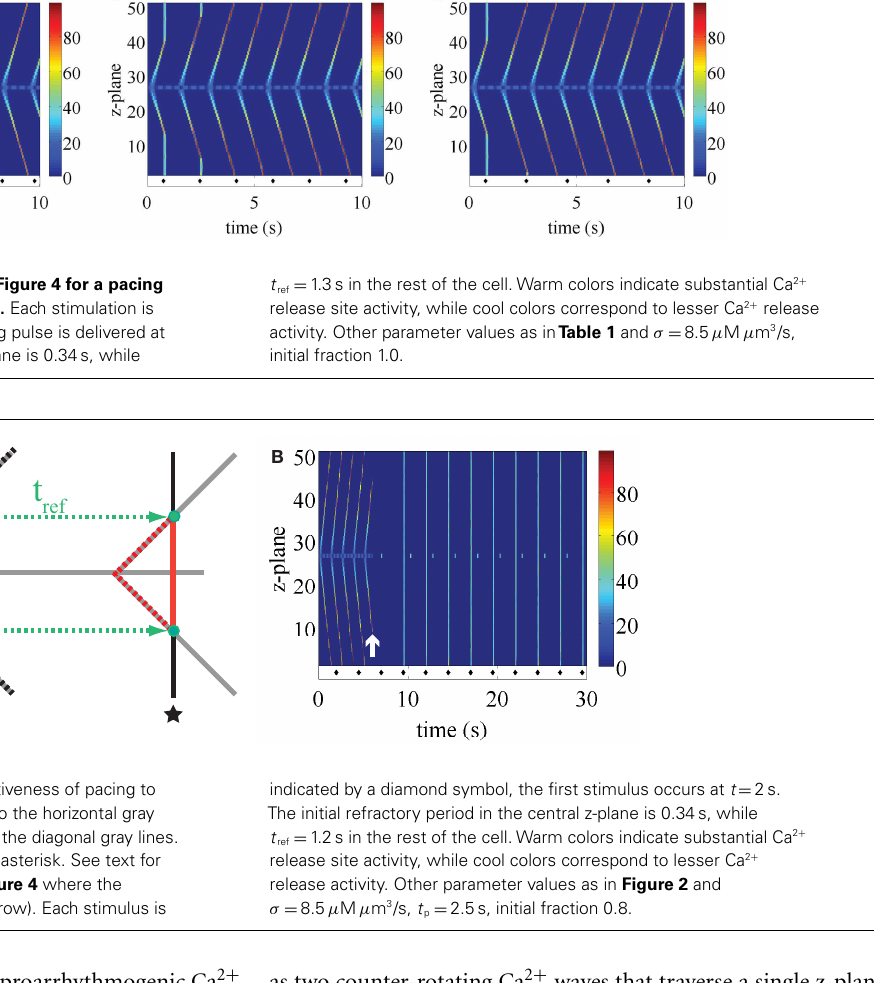
FIGURE 7 | (A) Cartoon illustrating the ineffectiveness of pacing to stop ping waves.The ping wave corresponds to the horizontal gray line, while the longitudinal wave is denoted by the diagonal gray lines. The pacing occurs at the time indicated by the asterisk. See text for details. (B) Paced ping wave initiated as in Figure 4 where the refractory period is doubled at t = 6s (white arrow). Each stimulus is